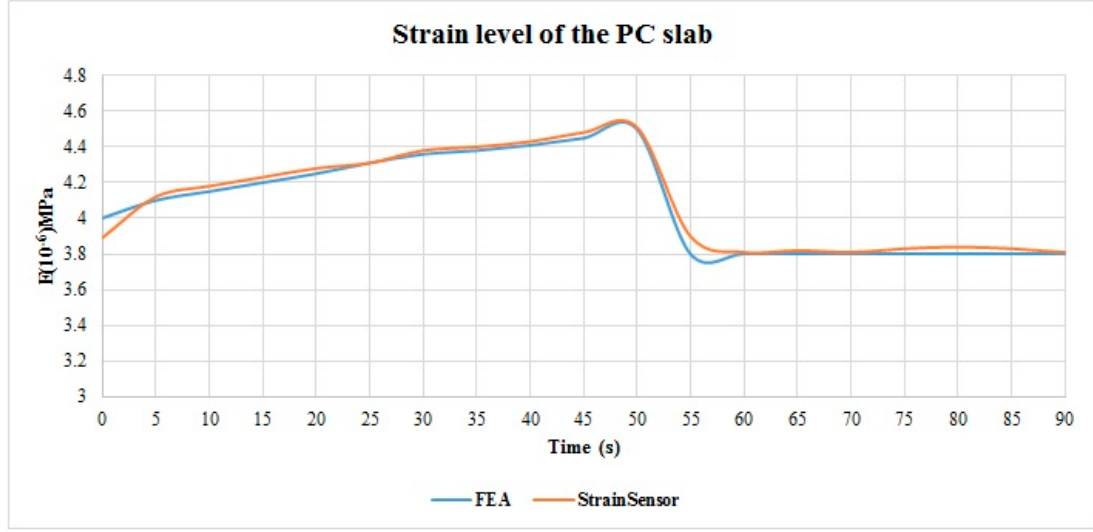
Figure 22. The strain level results of a PC slab obtained from FEA analysis and sensor monitoring.